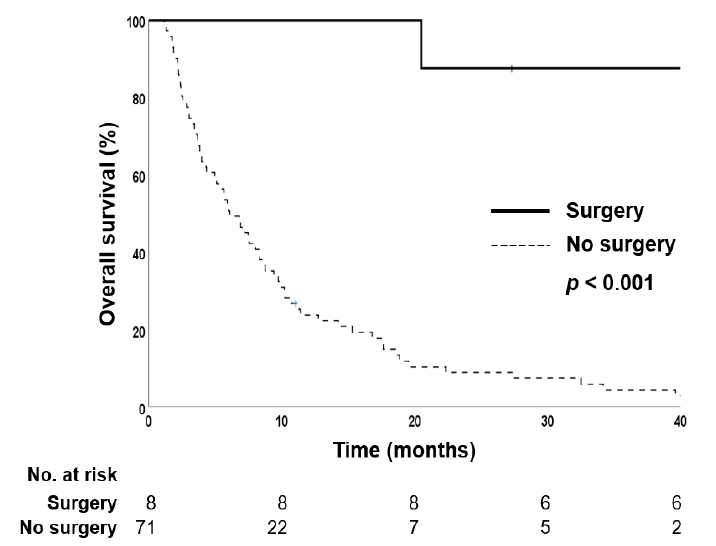
Figure 4. Kaplan–Meier estimates of overall survival in the propensity score-matched cohort according to surgical treatment.